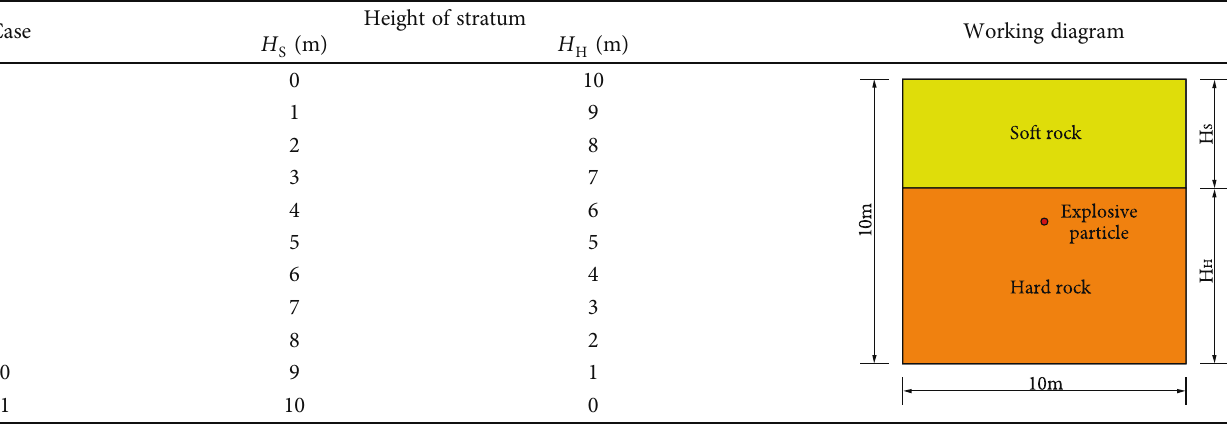
Table 3: Distribution cases of soft and hard rock